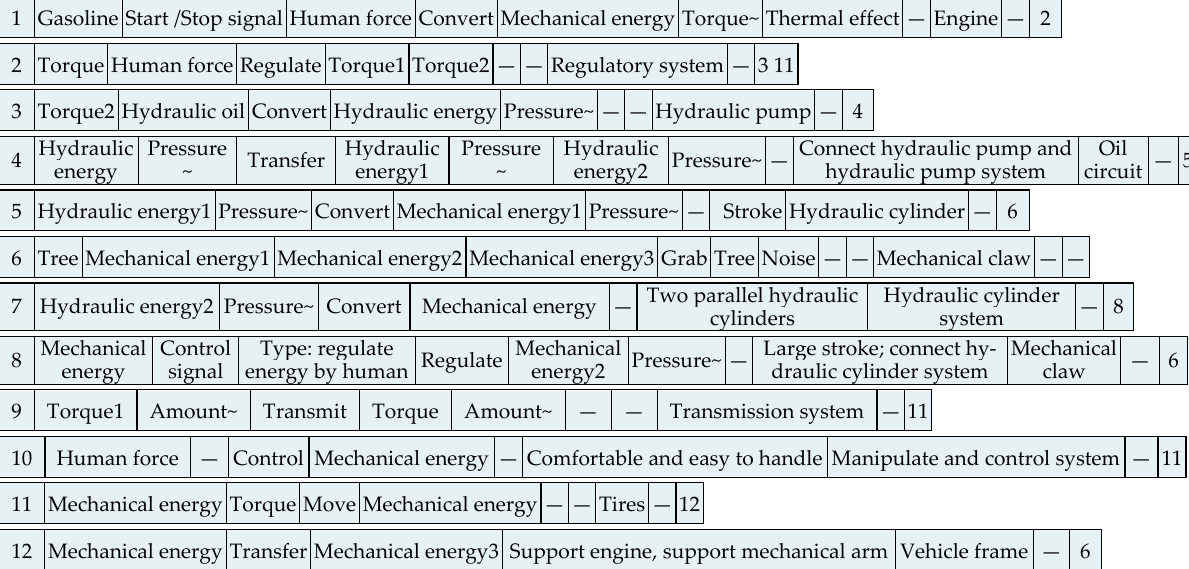
Figure 26. Product genome of the hydraulic wood gripper.